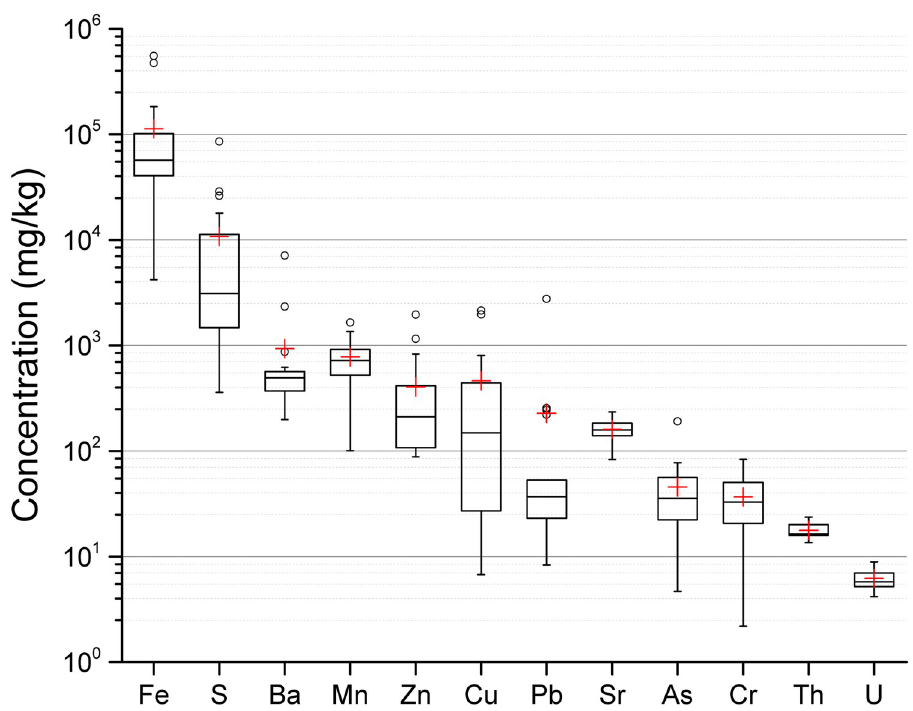
Fig 6. Element content per dry weight of surface sediment from 19 pit lakes, obtained by XRF analysis. The height of the box shows the interquartile range, which contains 50% of the values, the horizontal line inside the box shows the median value and the red cross denotes the mean value. The whiskers are lines that extend from the box to the highest and lowest values excluding outliers (o). Outliers represent those data with values being 1.5 higher or lower than the height of the box. Detailed data are given in supplementary data